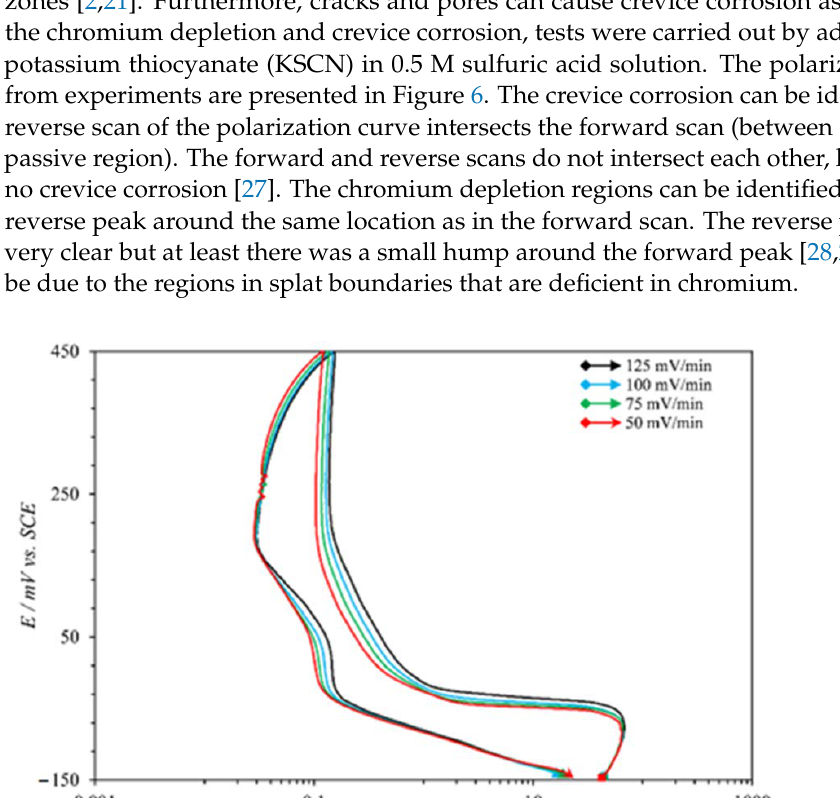
Table 6. Polarization results extracted in active regions at different scan rates. Mate- rial